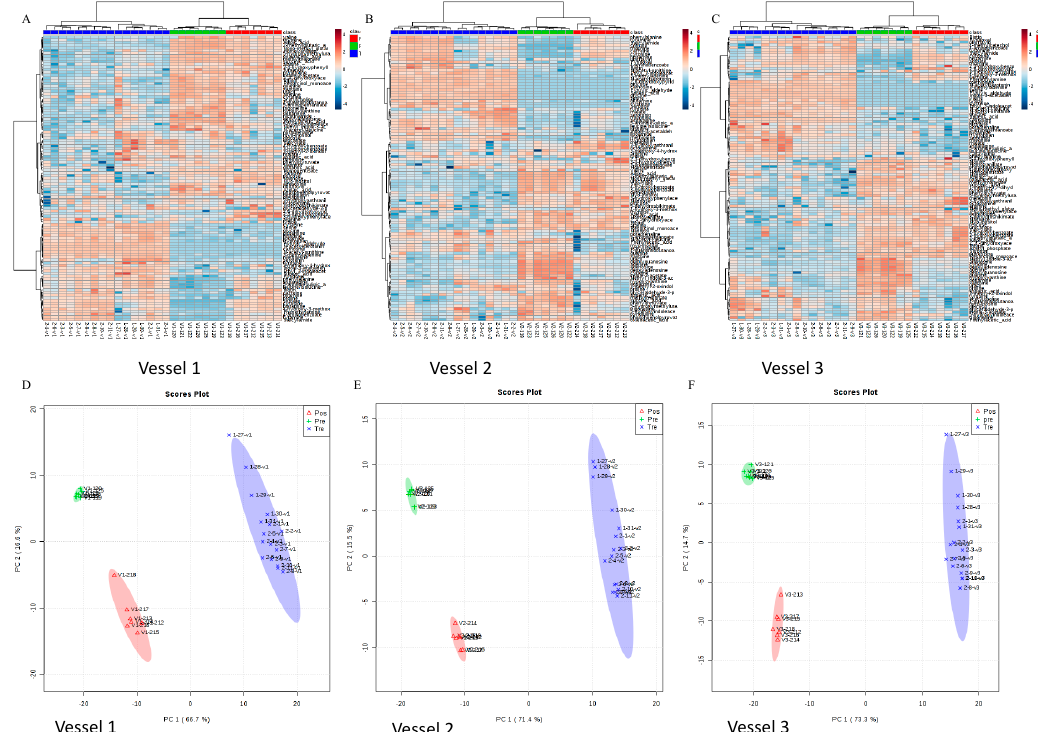
Figure 6. Heat map presentation of intracellular metabolic profiles computed by Euclidean distance and Ward’s hierarchical agglomerative clustering method ( A . Vessel 1; B . Vessel 2; C . Vessel 3). Principal component analysis (PCA) of 130 targeted metabolites comparison for pretreatment days, green tea treatment days, and post-treatment days ( D . Vessel 1; E . Vessel 2; F . Vessel 3).